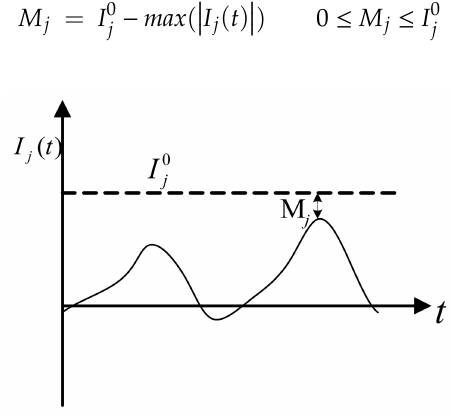
Figure 4. Time history curve of dynamic index j